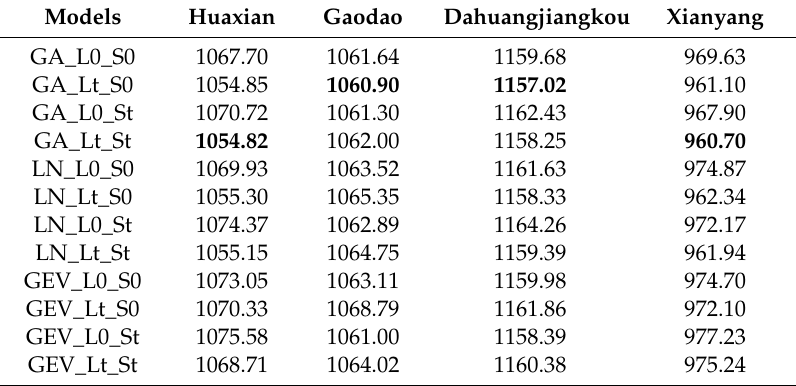
Table 3. Akaike information criterion (AIC) values of the non-stationary models for each station. Note that letter “L” in the models’ names represents location parameter and “S” represents scale parameters. Number “0” means the parameter is invariant while “t” means the parameter varies with time covariate. Besides, the AIC value in bold is the optimal model for each